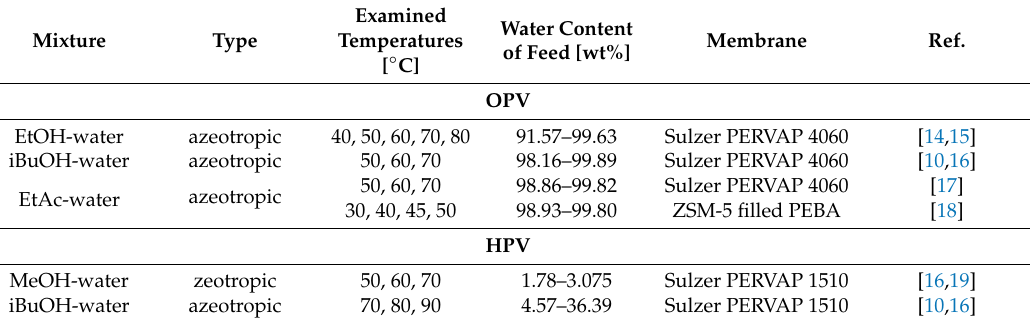
Table 1. Examined